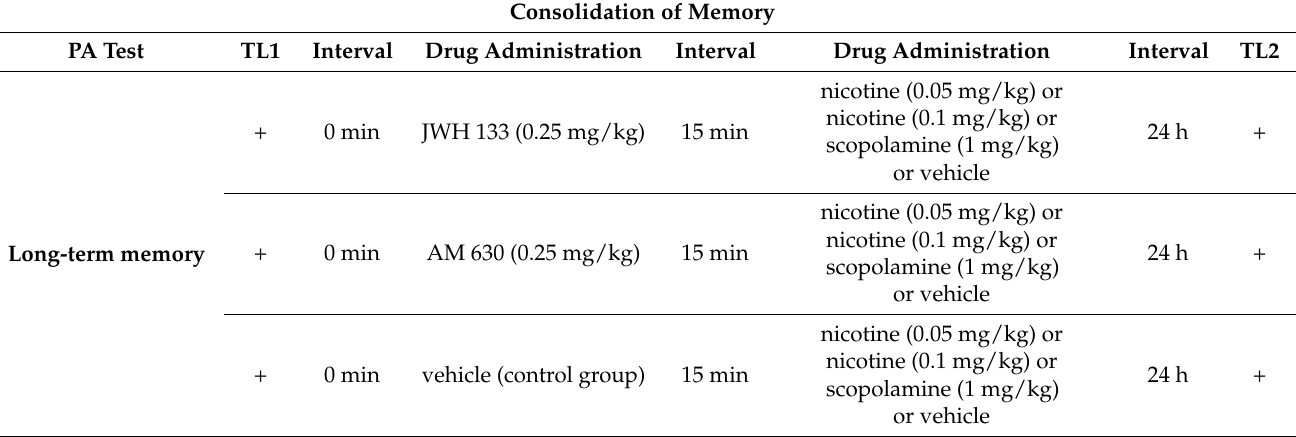
Table 4. The scheme of CB2 and cholinergic receptor ligands co-administration during the assessment of long-term memory consolidation in the PA test in